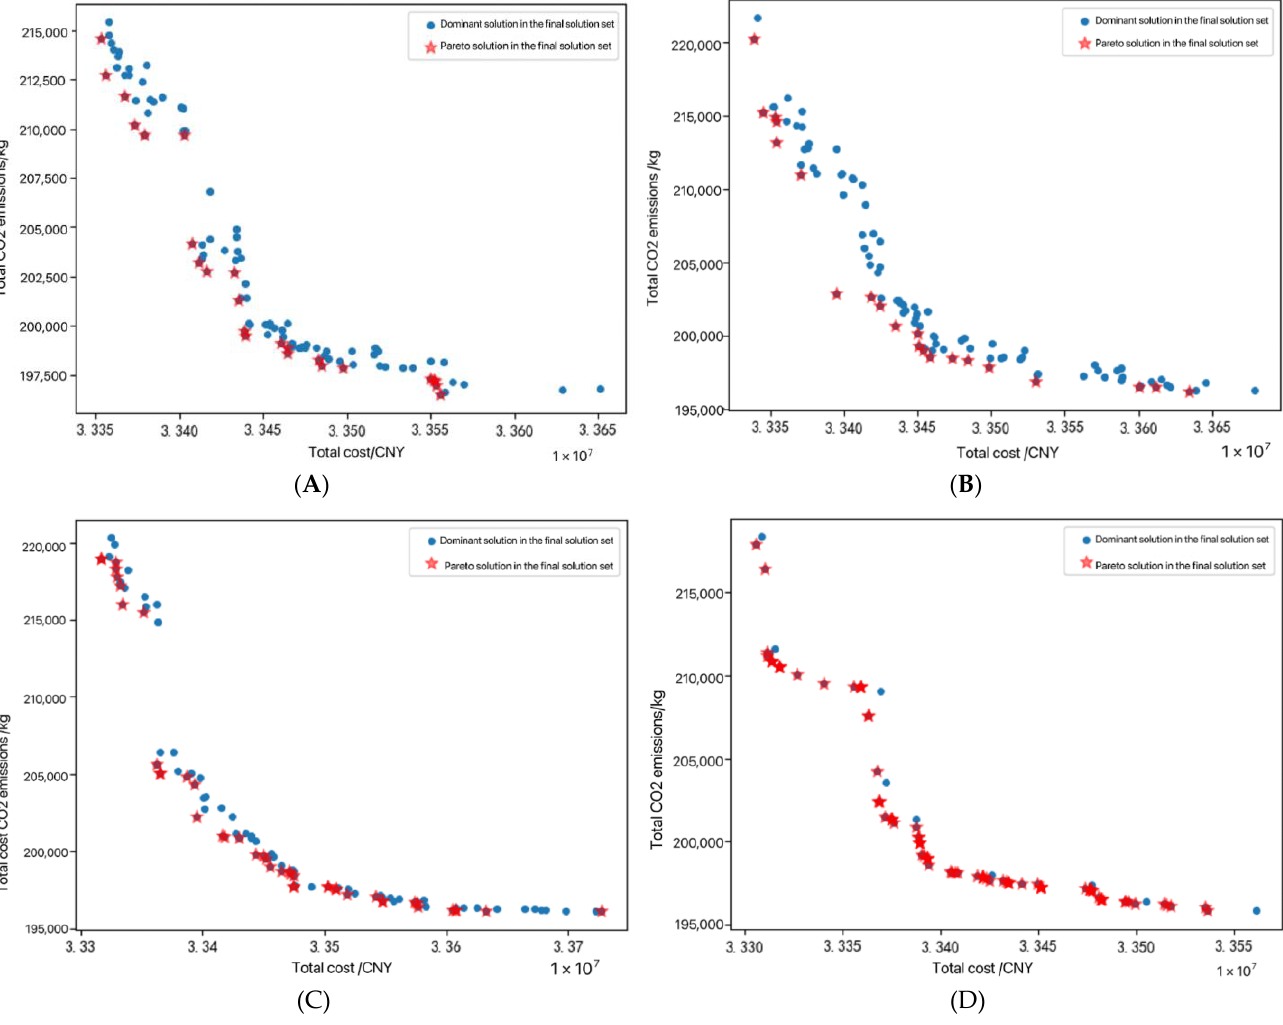
Figure 14. ( A ) Total cost vs. total carbon dioxide emissions relationship diagram (cross-variance probability is 0.9). ( B ) Total cost and total carbon dioxide emissions relationship diagram (cross-variance probability is 0.8). ( C ) Total cost versus total carbon dioxide emissions relationship diagram (cross-variance probability is 0.7). ( D ) Total cost and total carbon dioxide emissions relationship diagram (cross-variance probability is 0.6).